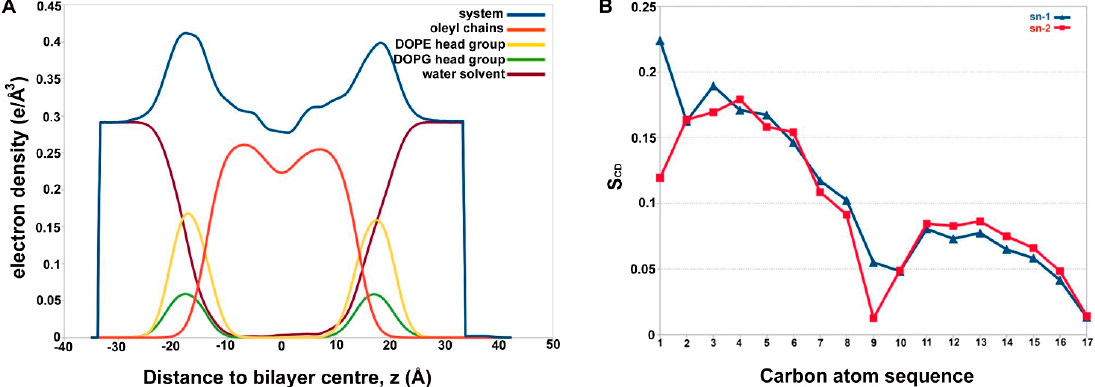
Figure 5. ( A ) The electron density profile for each constituent of membrane system and water calculated across the bilayer normal (Z-direction). A slight rise in the profile of water around 10 Å indicates presence of water in Alm F30 / 3 pore. Total electron density (in blue), the water density (brick red), the acyl tails of DOPE lipids (orange), the phosphoethanolamine lipid heads of DOPE (yellow) and phosphoglycerol heads of DOPG (green), ( B ) lipid order parameters of the acyl chains, | S CD | can be compared with previous experimental values. The acyl chains show high disorder that may be a result of presence of the Alm F30 / 3